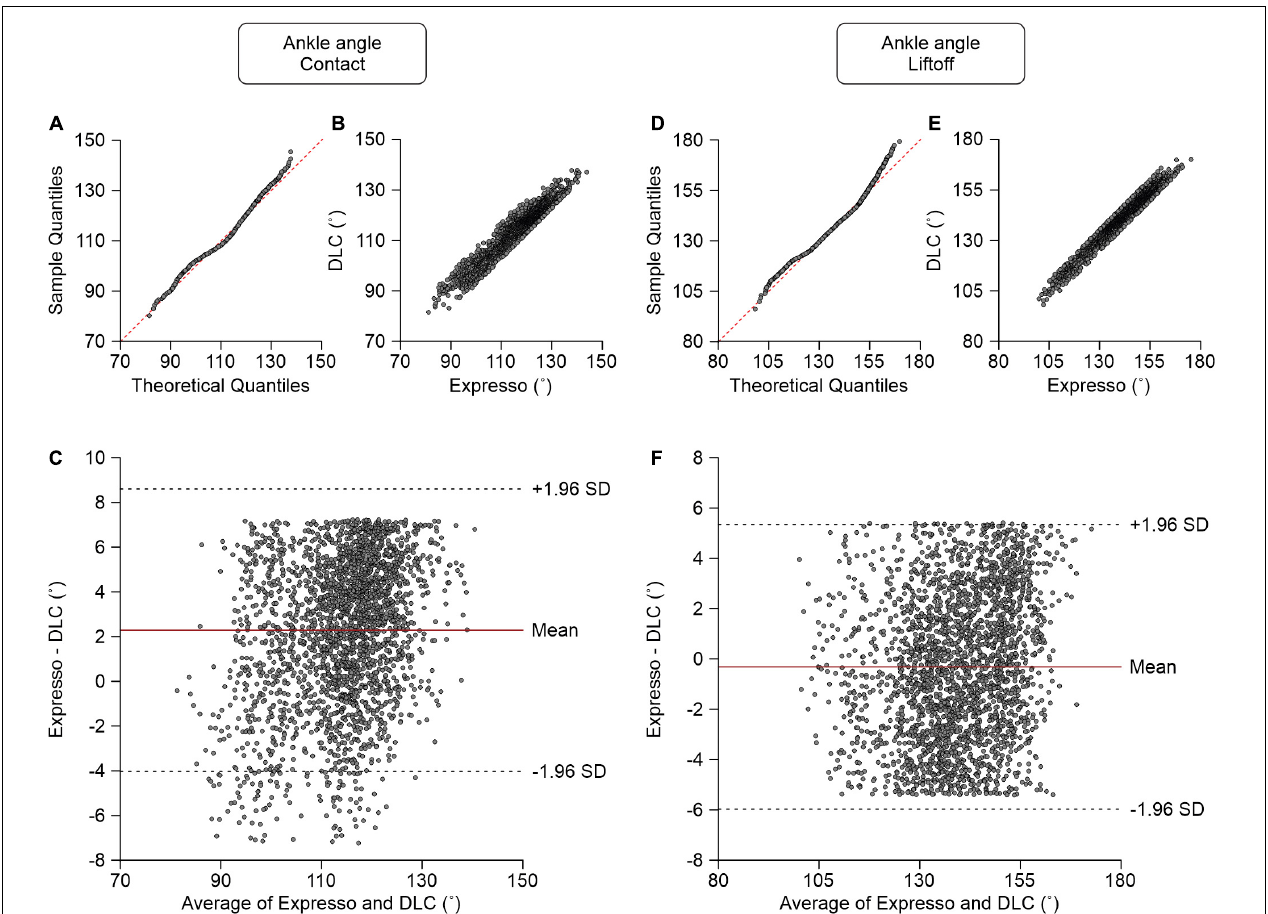
FIGURE 7 | Comparison of ankle joint angles at contact and at liftoff measured with data from Expresso and DLC. (A) Ankle angle at contact QQ-plot where the red dashed line represents a perfect normal distribution. (B) Ankle angle at contact scatter plot of values obtained with Expresso and DLC. (C) Bland–Altman plot of ankle angle at contact measurements from Expresso and DLC. The solid red line is the mean difference between the two methods and black dashed lines show ± 1.96 standard deviations. (D) Ankle angle at liftoff QQ-plot where the red dashed line represents a perfect normal distribution. (E) Ankle angle at liftoff scatter plot of values obtained with Expresso and DLC. (F) Bland–Altman plot of ankle angle at liftoff measurements from Expresso and DLC. The solid red line is the mean difference between two methods and black dashed lines show ± 1.96 standard